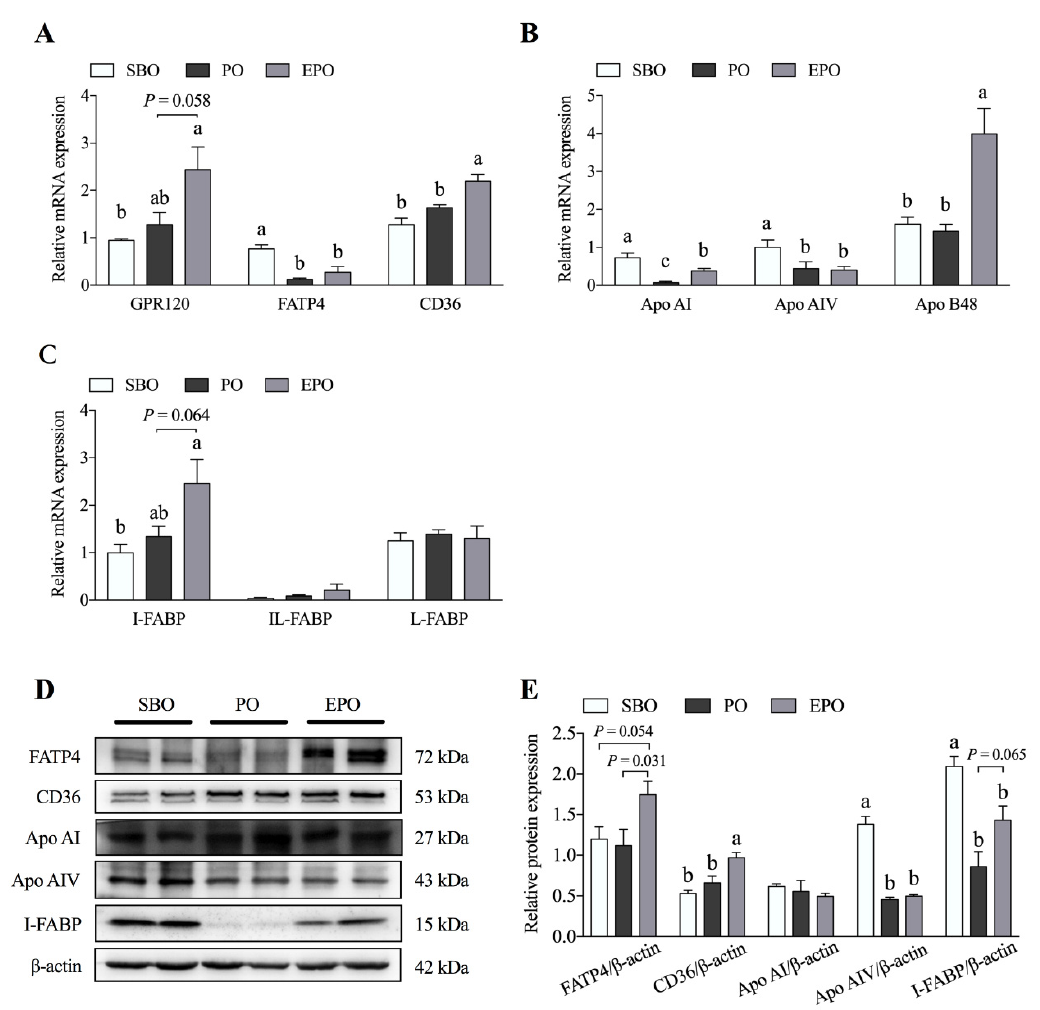
Figure 3. Expression of fatty acid transport system-related proteins in the porcine jejunum. The mRNA expression ( A – C ) and protein abundance ( D , E ) of proteins involved in fatty acid transport in the porcine jejunum. SBO, soybean oil group; PO, palm oil group; EPO, encapsulated palm oil group. Different letters (a, b, and c) indicate a significant difference among different groups ( p < 0.05).